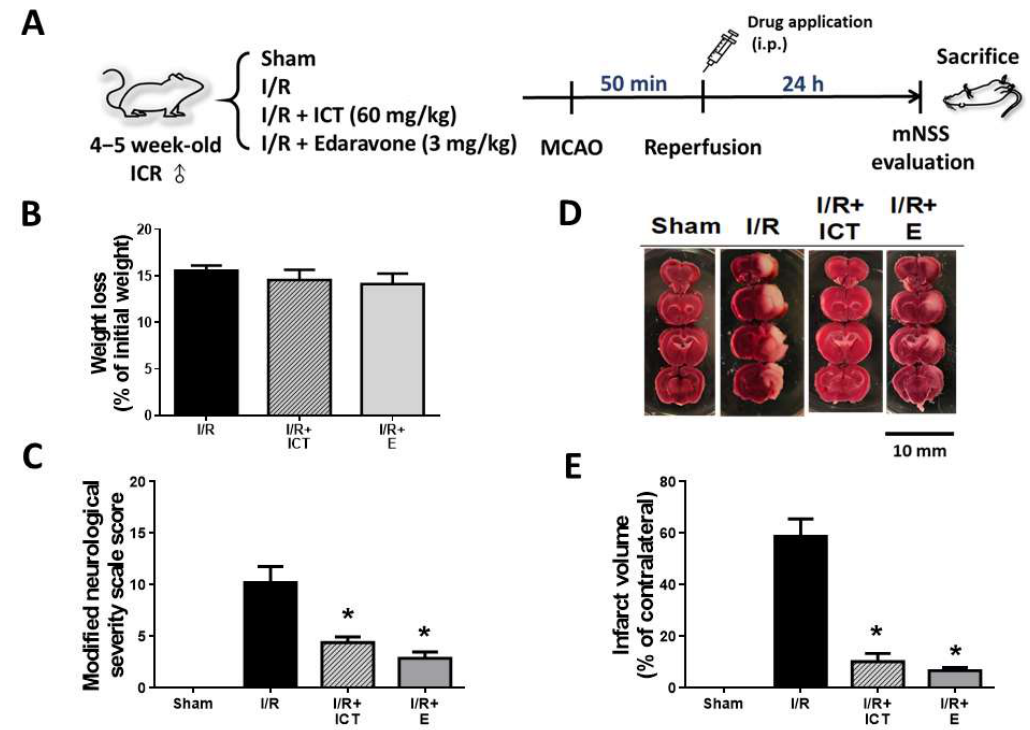
Figure 1. The therapeutic effects of icaritin (ICT) on body weight loss, neurological severity, and infarct volume in mice with acute cerebral ischemia-reperfusion. ( A ) Experimental flow chart of the therapeutic effect exerted by ICT in an acute cerebral ischemia/reperfusion injury mouse model. ( B – E ) Mice were treated with ICT (60 mg/kg) and edaravone (( E ); 3 mg/kg, as a positive control) after ischemia. The average body weight loss percentage of mice in each group was calculated ( B ). The modified neurological severity score (mNSS) in each group was evaluated ( C ). Photographs of the mouse cerebral infarct areas in each group ( D ). Quantification of infarct volume ( E ). Data are pre- sented as mean ± SD (n = 6). * p < 0.05 compared to the MCAO group.